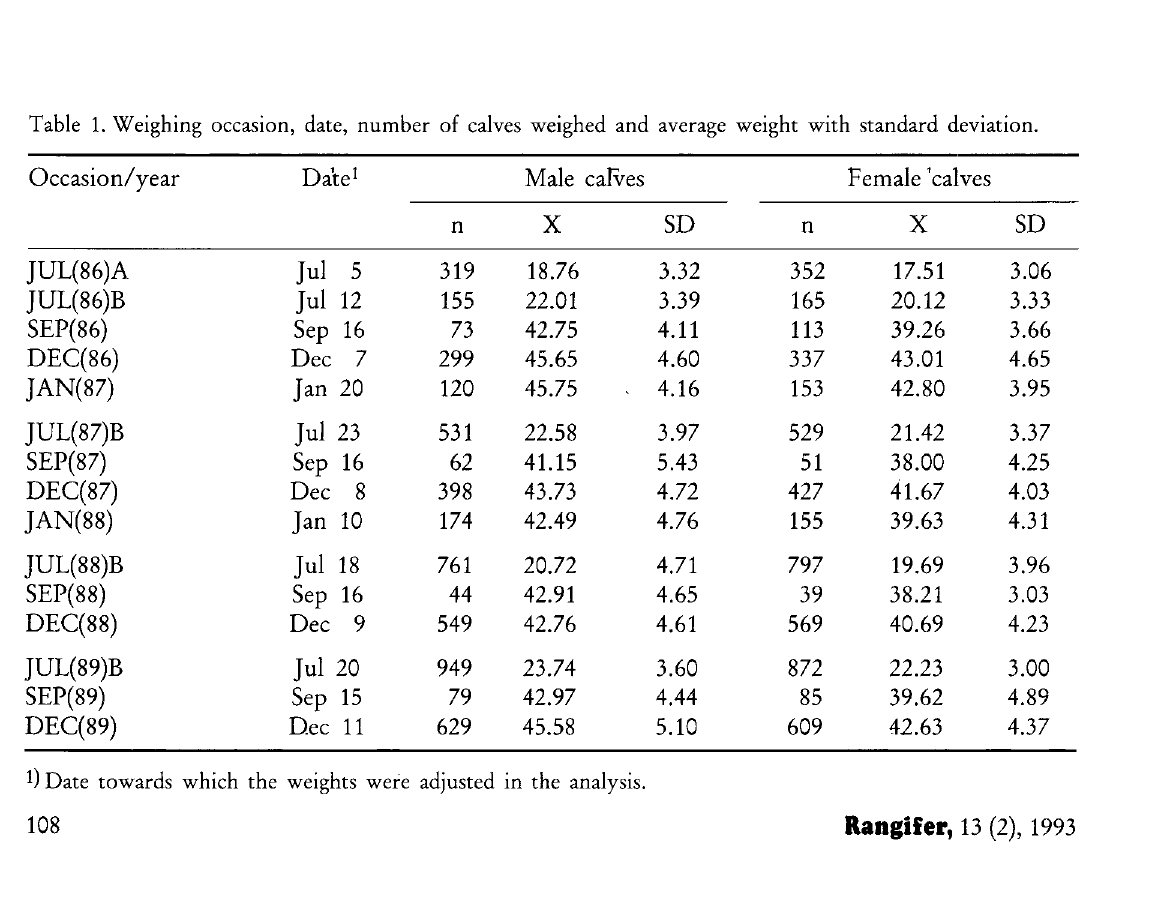
Table 1. Weighing occasion, date, number of calves weighed and average weight with standard